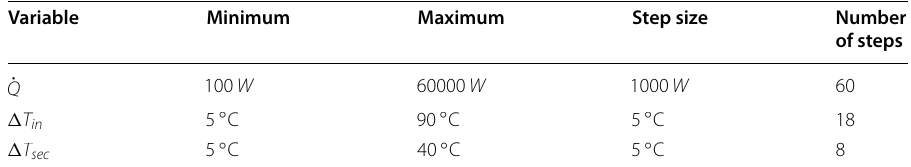
Table 2 Grid points of the CF